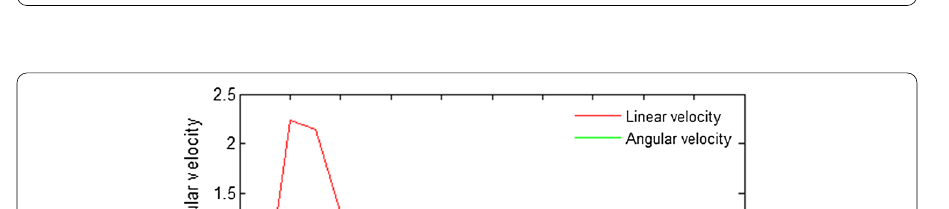
Fig. 7 Pose error curve of circular trajectory